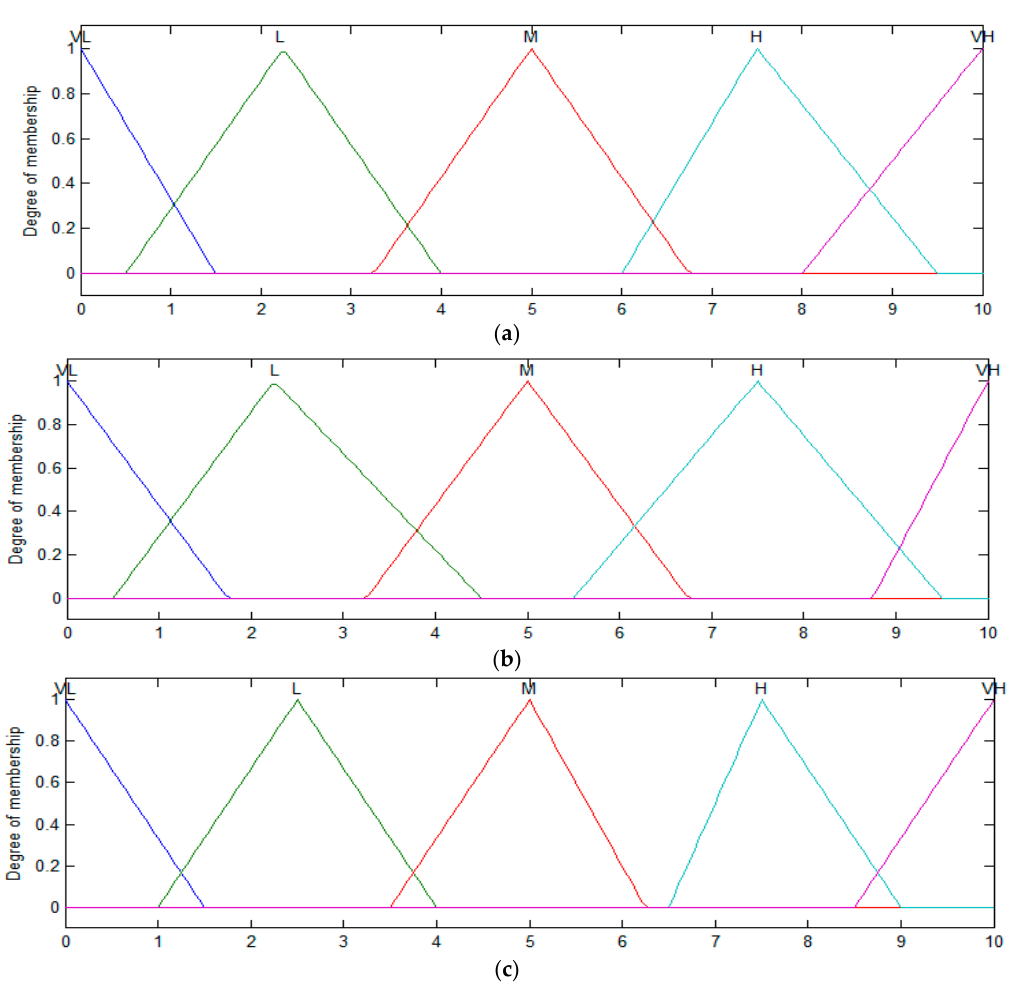
Figure 7. Input/output membership functions: ( a ) water supply risk probably; ( b ) water supply risk severity; and ( c ) water supply risk index.